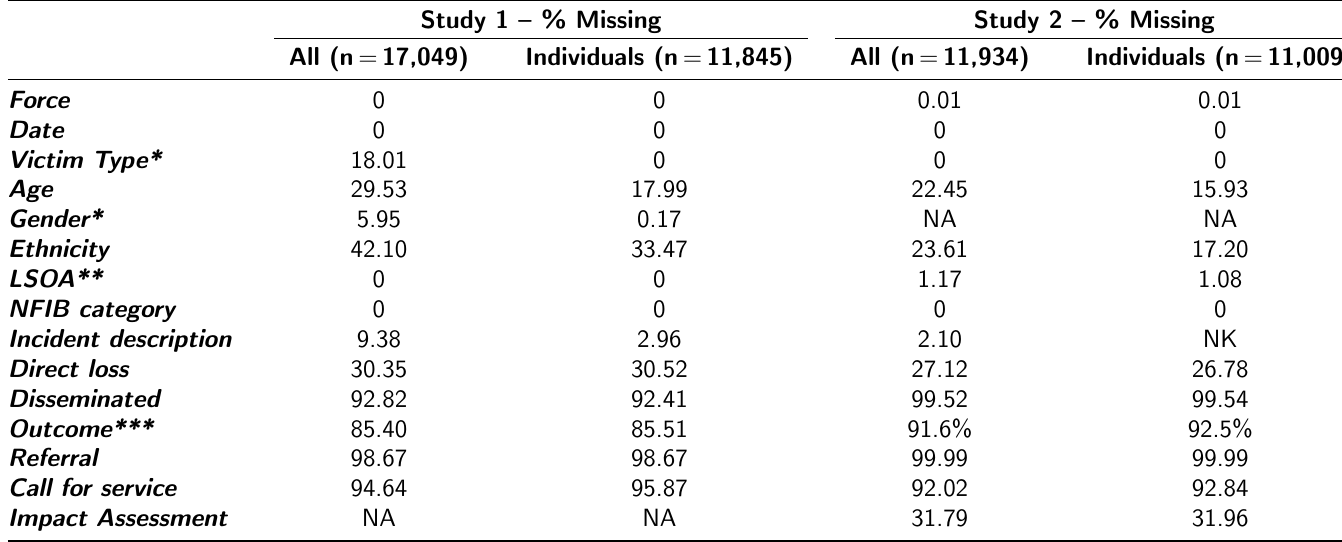
Table 4: Percentage of missing values per key variable, for all victims and for individual victims across studies 1 and